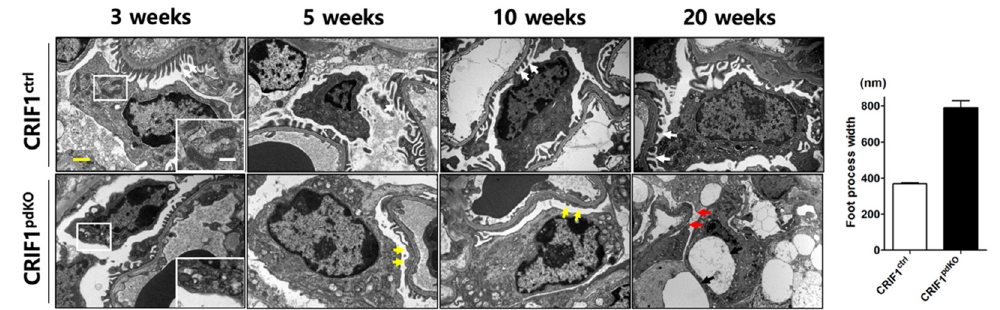
Figure 3. Transmission electron micrographs of renal sections from CRIF1 ctrl and CRIF1 pdKO mice at 3, 5, 10, and 20 weeks of age, and the foot process width of mice kidney at 5 weeks of age. White arrows in the panels showing 3-, 5-, 10-, and 20-week-old mice indicate foot process with normal structure. White boxes in the panel showing section from 3-week-old mice indicate mitochondria. The yellow arrows in the panel showing section from 5-week-old and 10-week-old CRIF1 pdKO mice indicate foot process fusion and effacement, and microvillous transformation. The red and black arrows in the panel showing a section from a 20-week-old CRIF1 pdKO mouse indicate extensive effacement and microvillous transformation of the foot processes, and podocyte degeneration and vacuolization, respectively. Yellow scale bar, 2 µ m. White scale bar, 1 µ